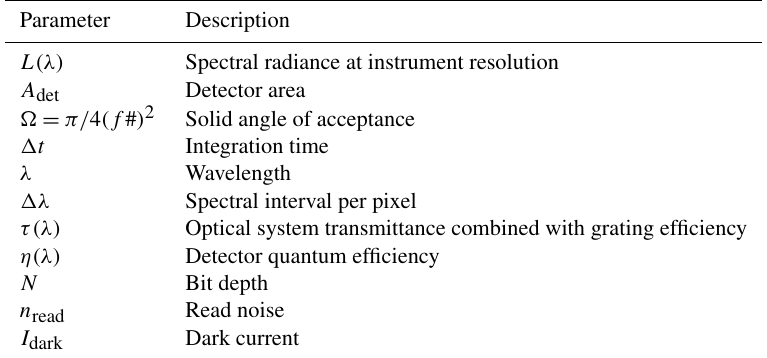
Table 2. ACX instrument response model parameters.